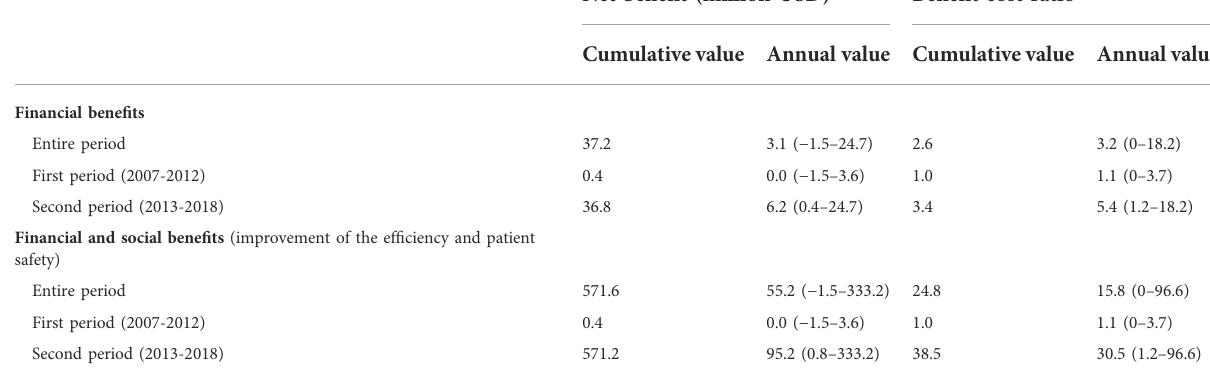
TABLE 3 Results of the cost-bene fi t analysis of the base case and scenarios.